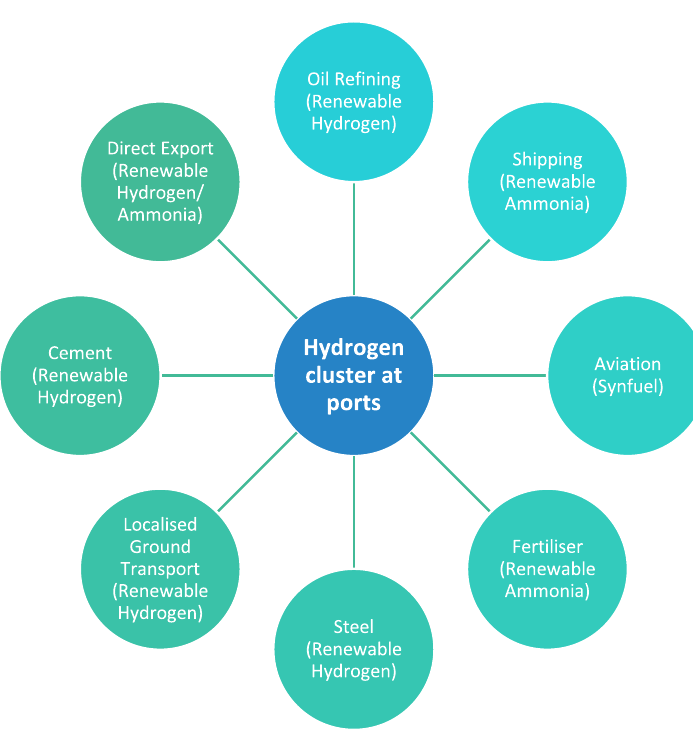
Fig. 6 Potential strategic applications of hydrogen clustered at ports. Author